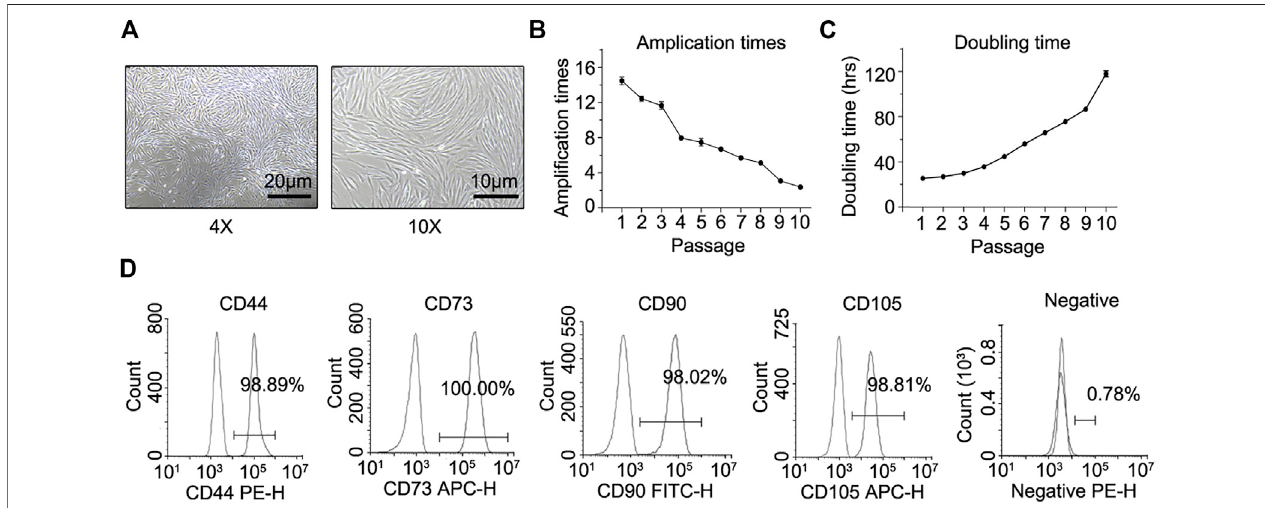
FIGURE 1| In vitro culture, proliferation properties, and mesenchymal lineage surface markers of hHF-MSCs. (A) hHF-MSCs morphology under light microscope. (B) Ampli fi cation times of hHF-MSCs from passage 1 to passage 10. (C) Doubling time of hHF-MSCs from passage 1 to passage 10. hrs: hours. (D) Flow cytometry analysisonmesenchymallineagesurfacemarkersofhHF-MSCsincludingCD44 + ,CD73 + ,CD90 + ,CD105 + ,CD11b − ,CD19 − ,CD34 − ,CD45 − ,andHLA-DR - .Allthedata were obtained from three independent experiments. Data were shown as the means ±